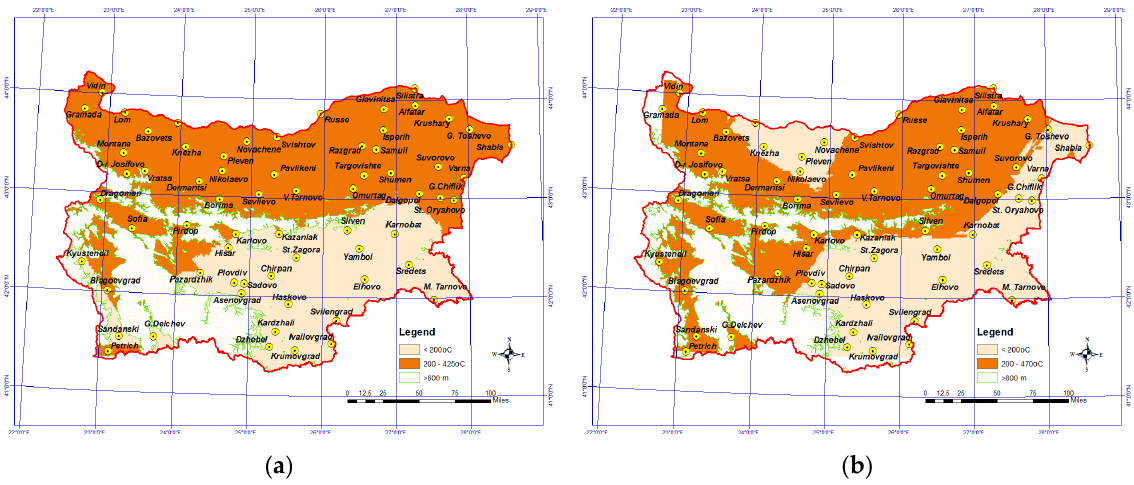
Figure 7. Deviations in sums of temperature during the period with temperatures above 5 ◦ C ( a ) and 10 ◦ C ( b